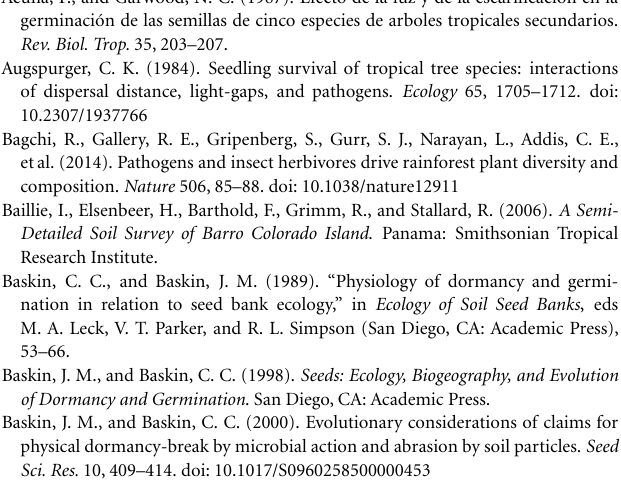
temperature, as suggested for Ochroma seeds (see Vazquez-Yanes,